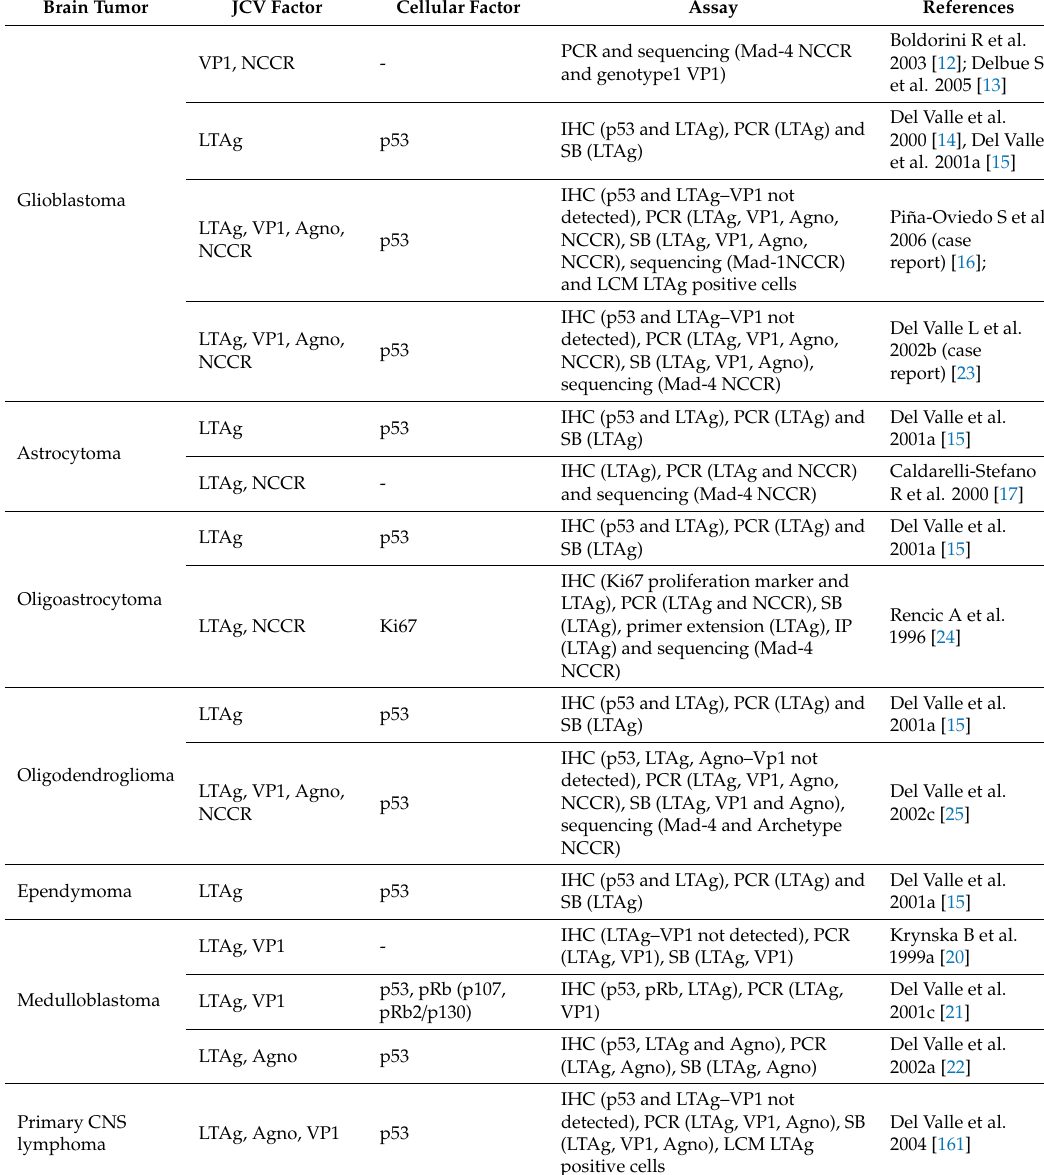
Table 3. Association between JCV and human brain tumors in the absence of